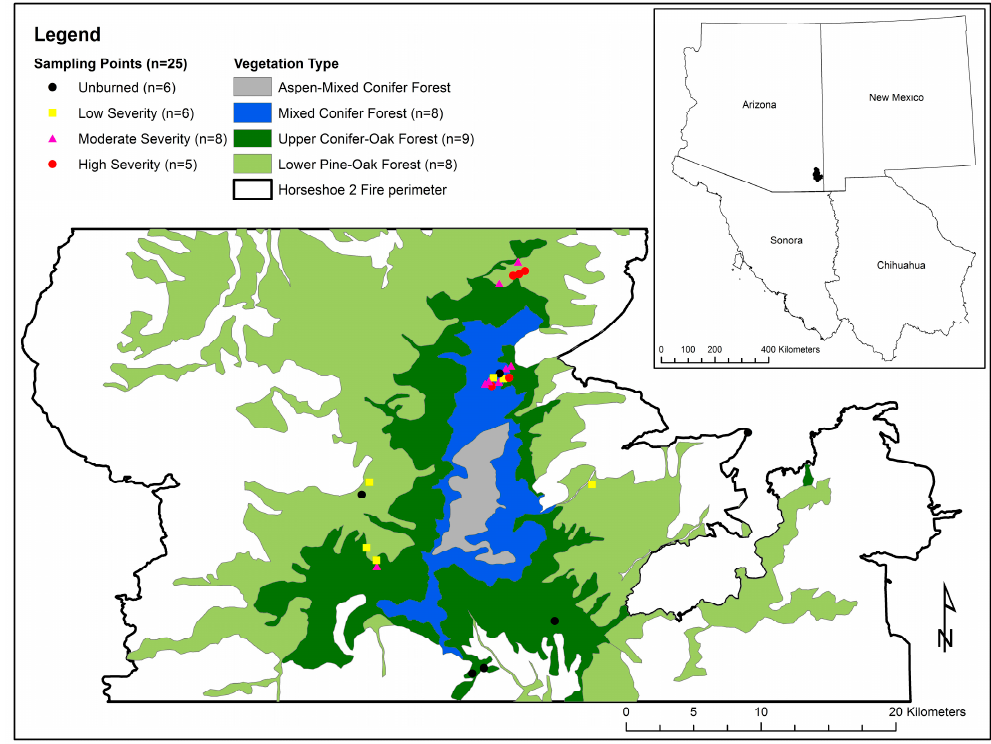
Figure 1. Plot locations within three Ecological Systems in the Chiricahua Mountains, Arizona, USA. White areas within the Horseshoe 2 Fire perimeter correspond to xeric grassland, savanna, and woodland vegetation types that were not included in this analysis. Plot frequencies are indicated by both fire severity and vegetation type. No plots were sampled within the high-elevation Aspen-Mixed Conifer vegetation